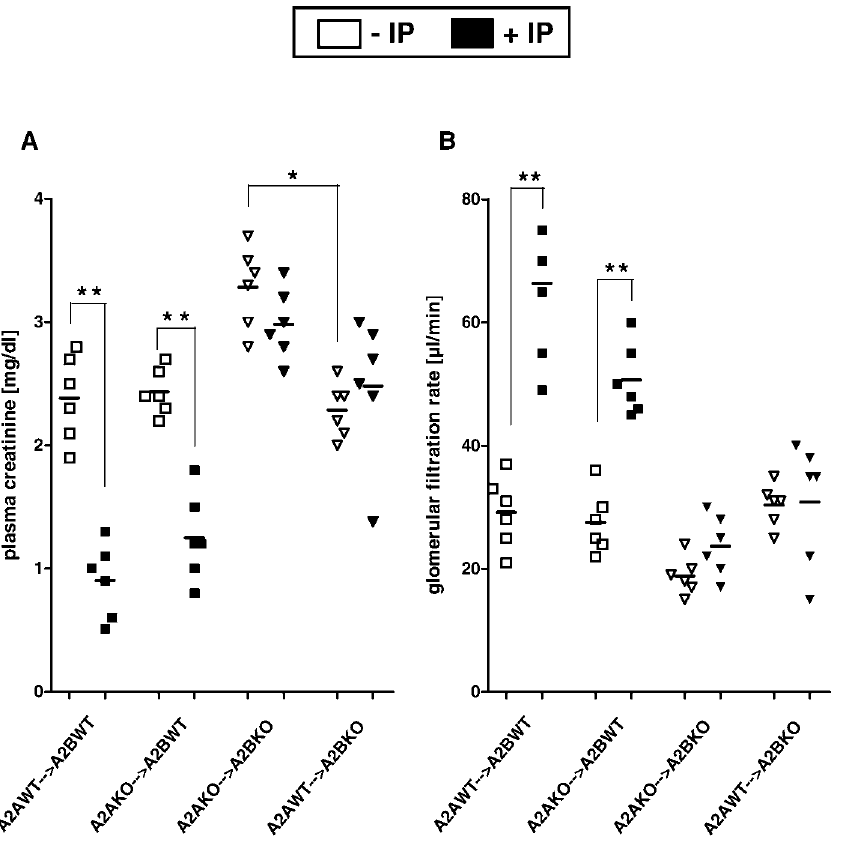
Figure 11. Renal Ischemia and Preconditioning in A2A/A2B AR Bone Marrow Chimeric Mice A2BAR þ / þ (A2BWT) or A2BAR (cid:2) / (cid:2) (A2BKO) mice underwent lethal radiation followed by bone marrow transplantation with marrow derived from A2AAR þ / þ (A2AWT) or A2AAR (cid:2) / (cid:2) (A2AKO) mice. Experiments were performed 8 wk following transplantation. Mice underwent right nephrectomy and underwent 45 min of left renal artery ischemia with or without prior IP (consisting of four cycles of 4 min ischemia followed by 4 min reperfusion). Following 24 h of reperfusion time, (A) plasma creatinine and (B) GFRs were measured. Statistics: One-way ANOVA with Tukey’s post-hoc test was performed (**, p , 0.001 versus the respective group with IP; *, p , 0.001 versus A2AWT ! A2BKO). The F -test results are (A) F (7,40) ¼ 32.45, p , 0.001; (B) F (7,40) ¼ 29.67, p , 0.001.